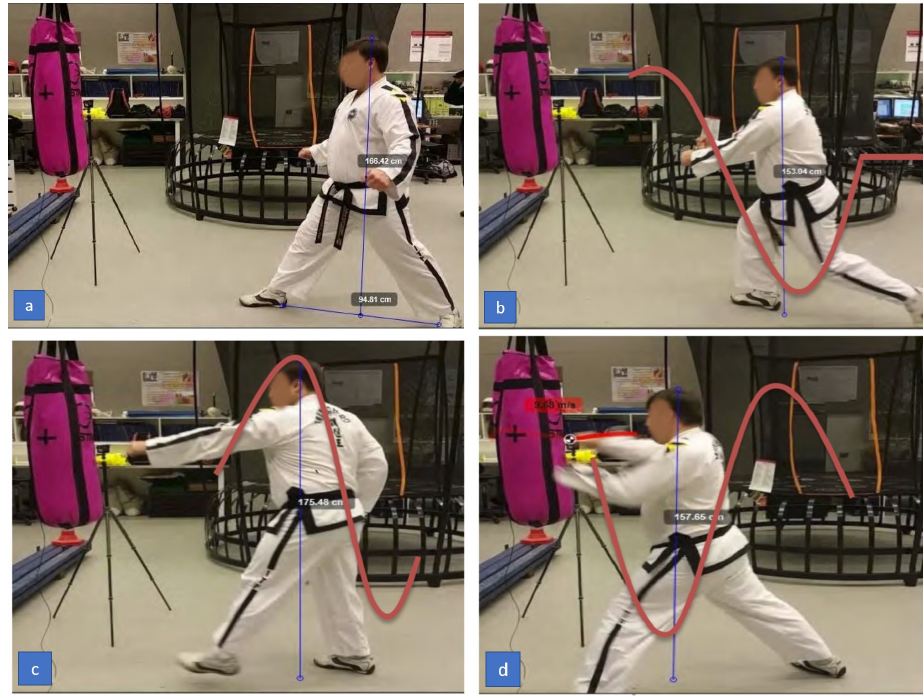
Figure 10. Taekwondo sine-wave punch motion ( a ) preparation phase ( b ) forward step and lowering height ( c ) pulling back the striking hand and increasing height ( d ) extending punching hand and dropping height